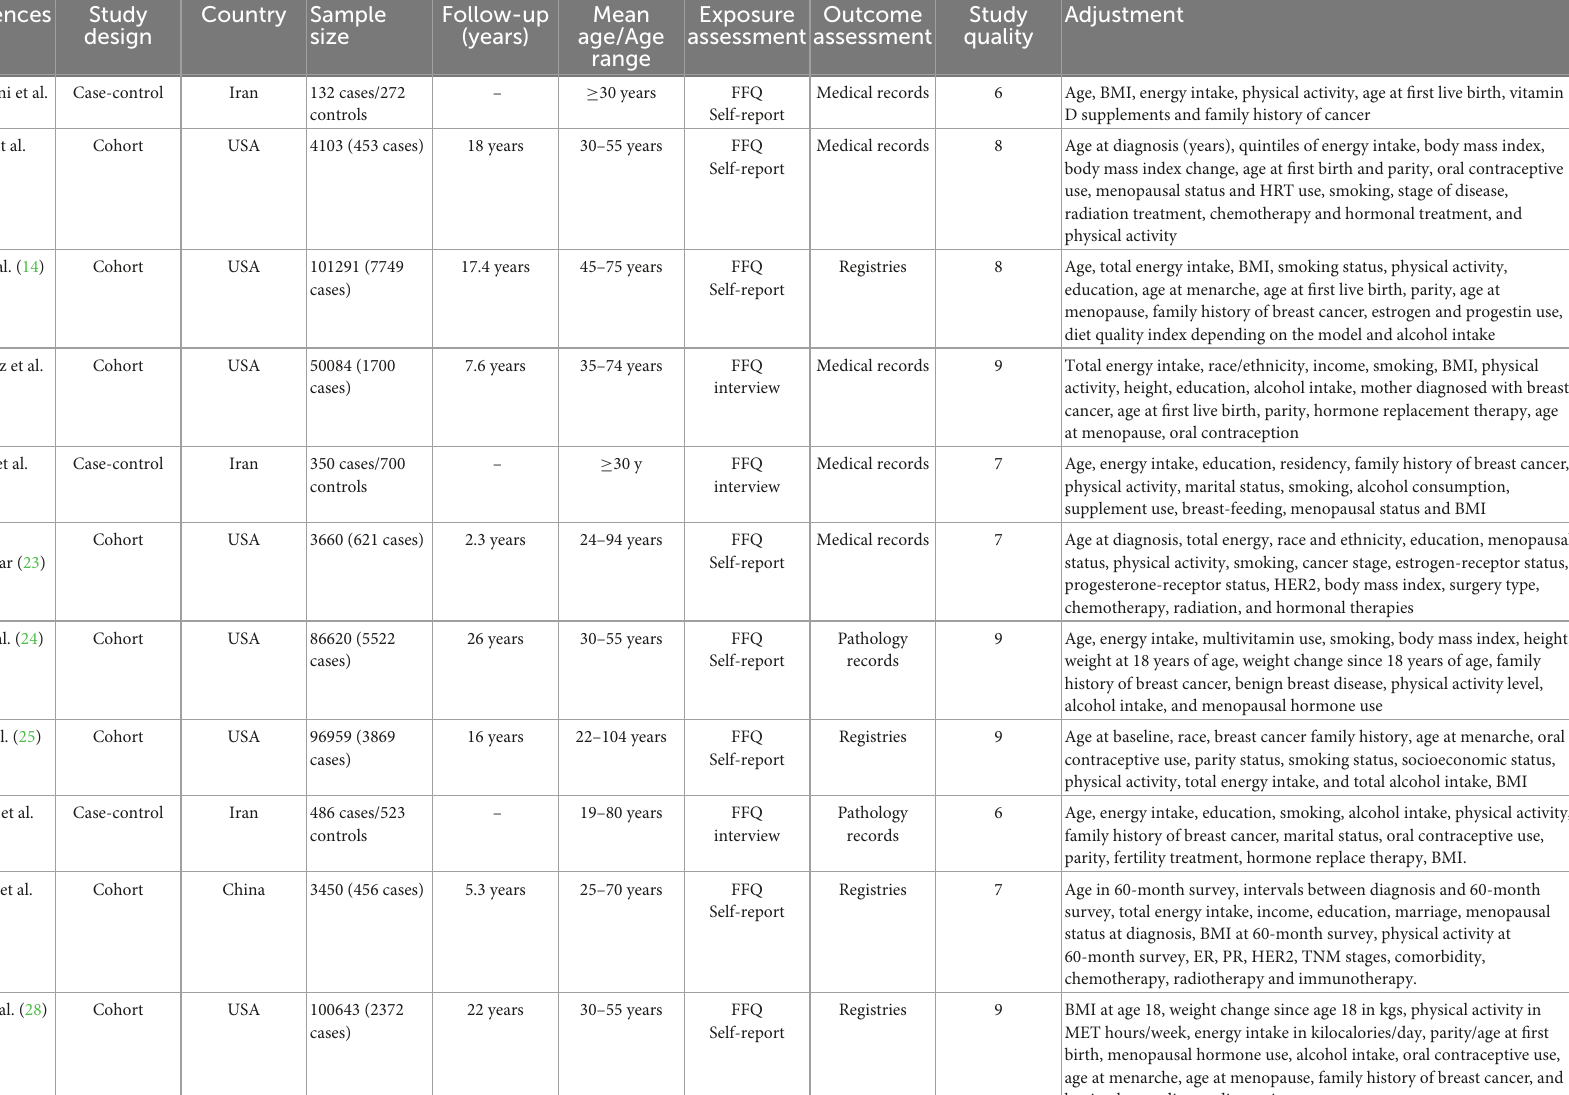
TABLE 1 Characteristics of the included studies on the association between DASH diet and risk of breast